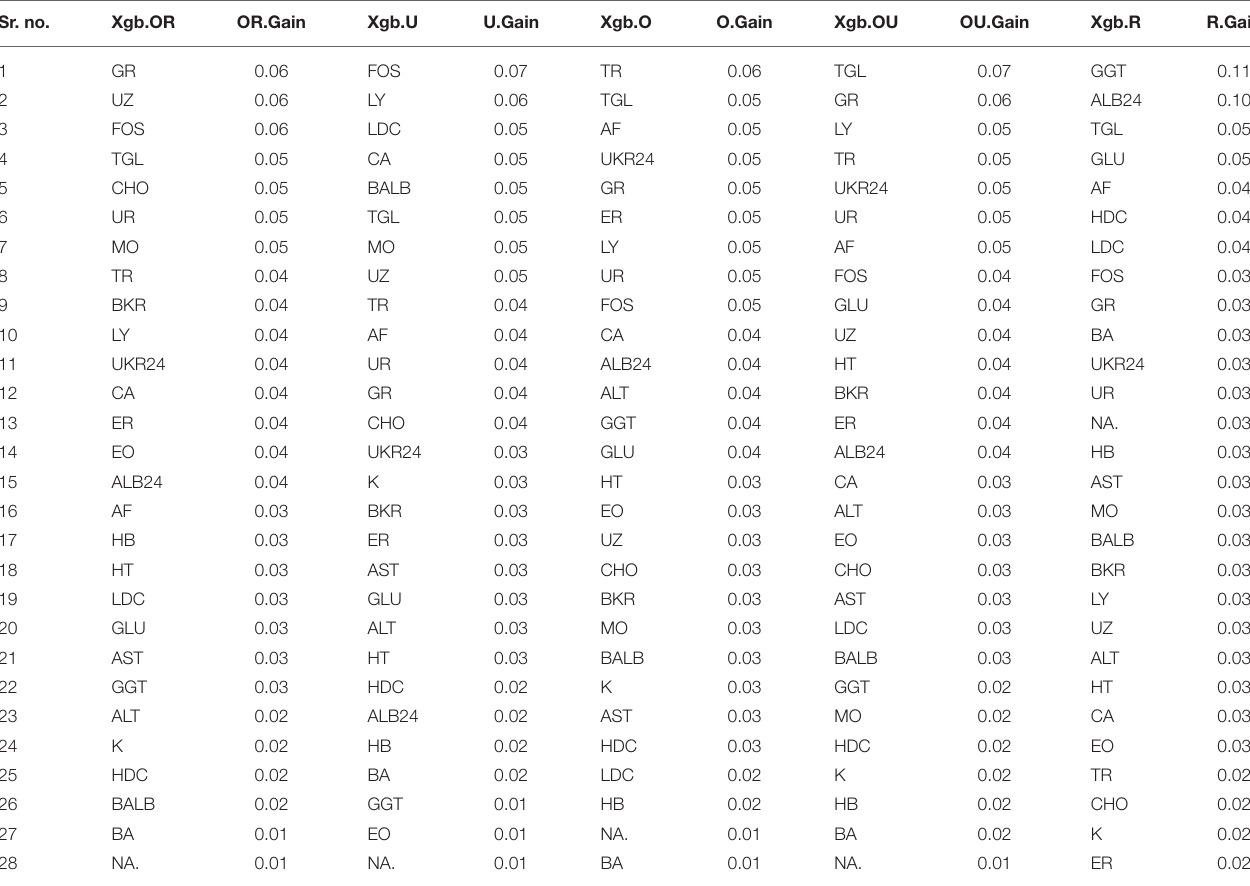
TABLE 4 | Variable importance extracted from different XGBoost models. Sr. no. Xgb.OR OR.Gain Xgb.U U.Gain Xgb.O O.Gain Xgb.OU OU.Gain Xgb.R